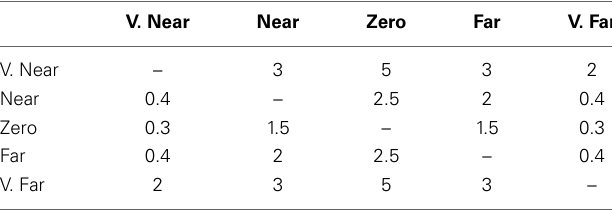
Table 2 | The inhibition coefficients M dd (cid:2) that define line-of-sight